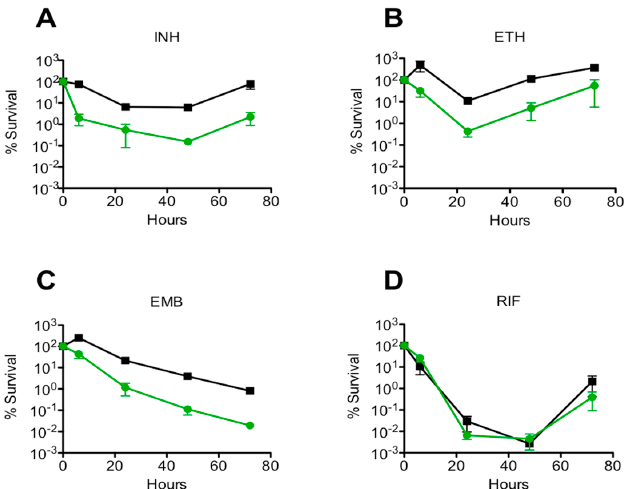
Figure 3. Batch culture drug-killing assay for the msm0031 transposon mutant (green circles) and wild-type M. smegmatis cells (black squares). ( A ) INH, 50 µ g/mL; ( B ) ETH, 200 µ g/mL; ( C ) EMB, 5 µ g/mL; and, ( D ) RIF, 200 µ g/mL. Results are the means and standard errors from 3 independent experiments. Table 1. Fractional survival ratio (FSR) for the msm0031 transposon mutant and wild-type M. smegmatis